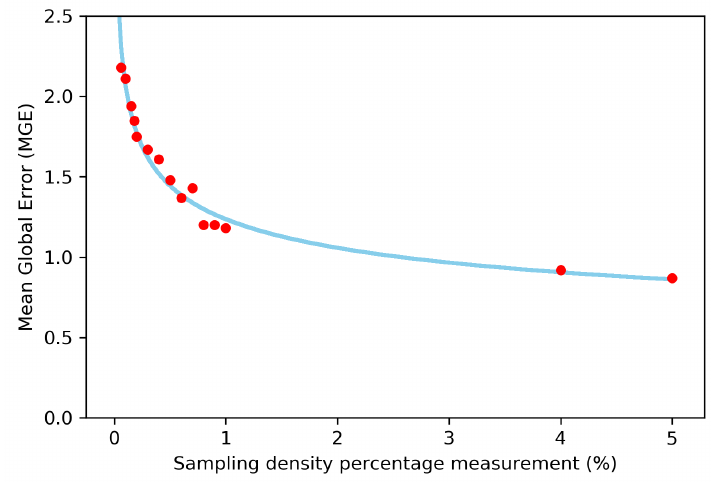
Figure 11. Mean global error versus the equivalent sampling